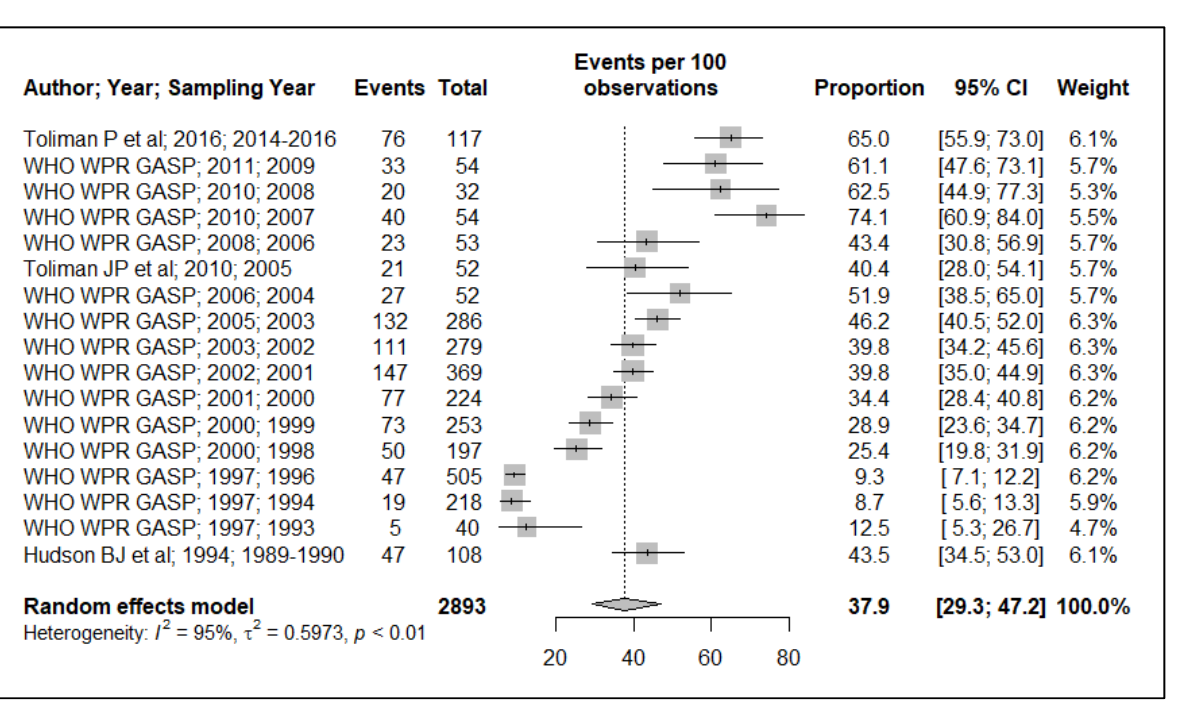
Figure 1. PRISMA [19] flow chart of article search, article inclusion and exclusion, and the number of studies included in this study-systematic review and meta-analysis.